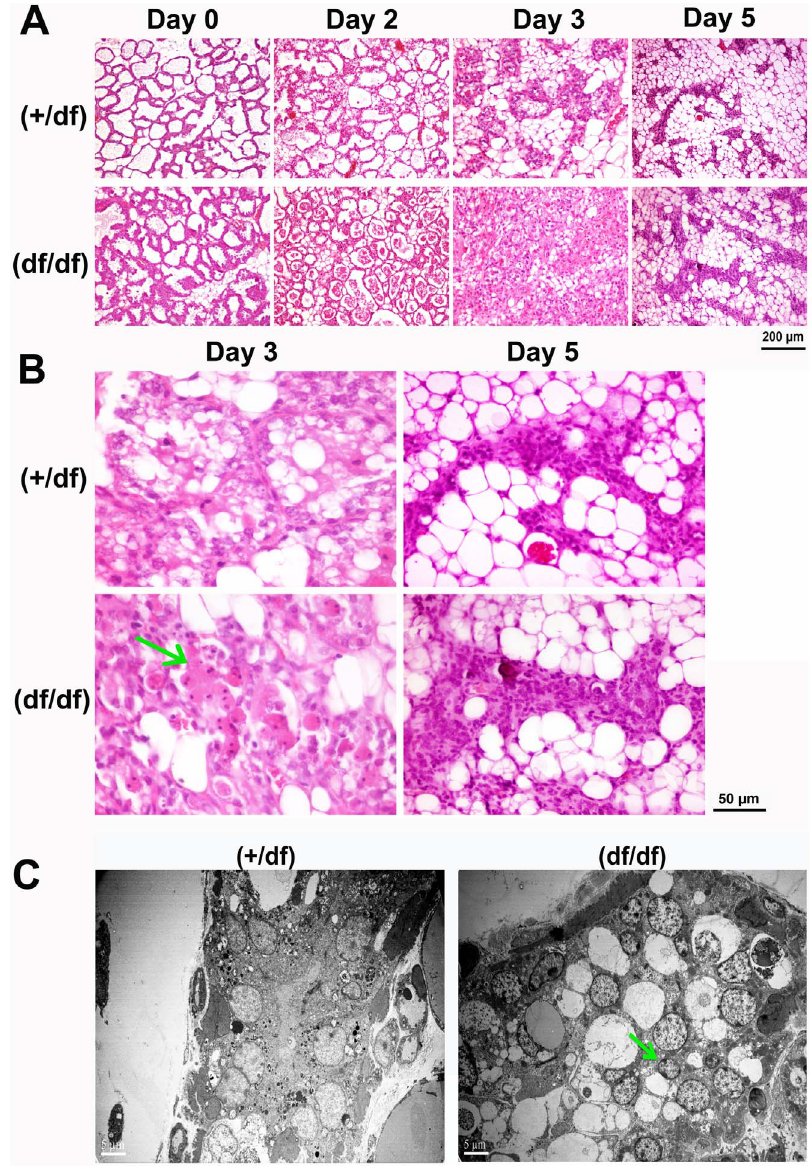
Figure 5. Dab2 deficient mammary glands have delayed involution. A control ( dab2 heterozygous) and dab2 knockout ( dab2 (f/df):Sox2-Cre) group of six 6-month old mice were mated, became pregnant, gave birth, and nursed an equal number (six) of pups per mouse. At day 12 of lactation, the mice underwent forced involution by removal of the pups. Mammary glands were harvested accordingly for histological analysis. Consistent results were obtained in two independent experiments using deletion by either Meox2-Cre or Sox2-Cre. ( A ) Representative H&E images show the morphology of the mammary glands. ( B ) Images of higher magnification are shown for day 3 and 5 of involution. Accumulating apoptotic cells in the lumen are indicated by a green arrow. ( C ) Mammary tissues of heterozygous and dab2 knockout at day 3 of forced involution were analyzed by transmission electron microscopy. An arrow indicates the presence of cells in the interior of the dab2 knockout mammary lumens.